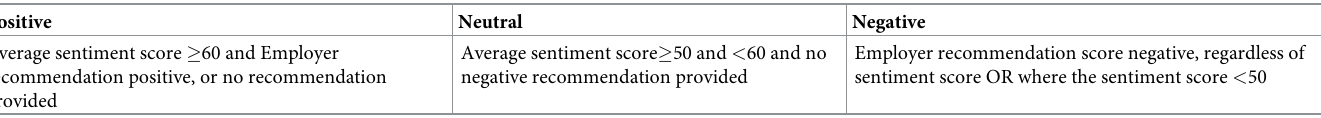
Table 2. Criteria for assigning overall sentiment